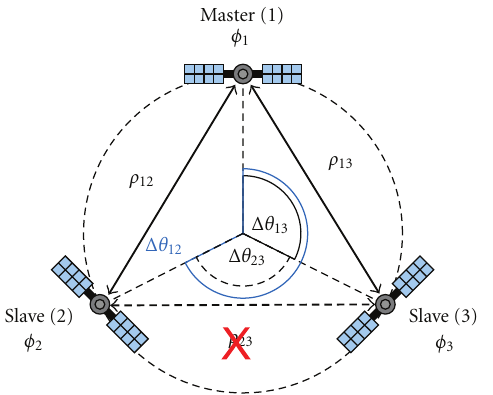
Figure 6: Three-satellite constellation for the Master-Slave analysis with elevation angles φ , azimuth angle separations Δ θ , and correlation coe ffi cients ρ .